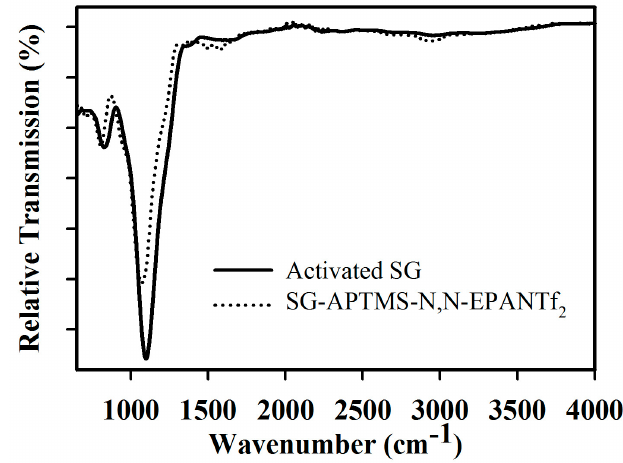
Figure 1. FT-IR spectra of activated SG and SG-APTMS-N,N-EPANTf 2 phases.